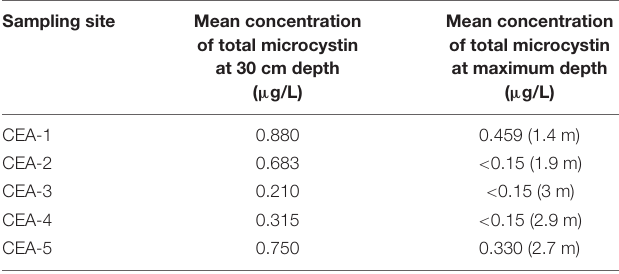
TABLE 3 | Total microcystin concentration in water samples from Lake Cajititlán. Sampling